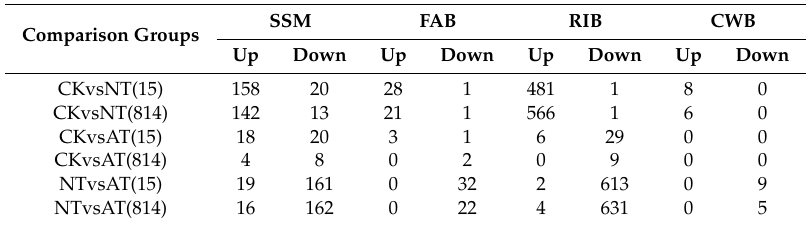
Table 2. Numbers of up- and downregulated genes in starch and sucrose metabolism (SSM), fatty acid biosynthesis (FAB), ribosome (RIB), and cell wall biogenesis (CWB) in the six comparison